Question: Name the type of graph shown.
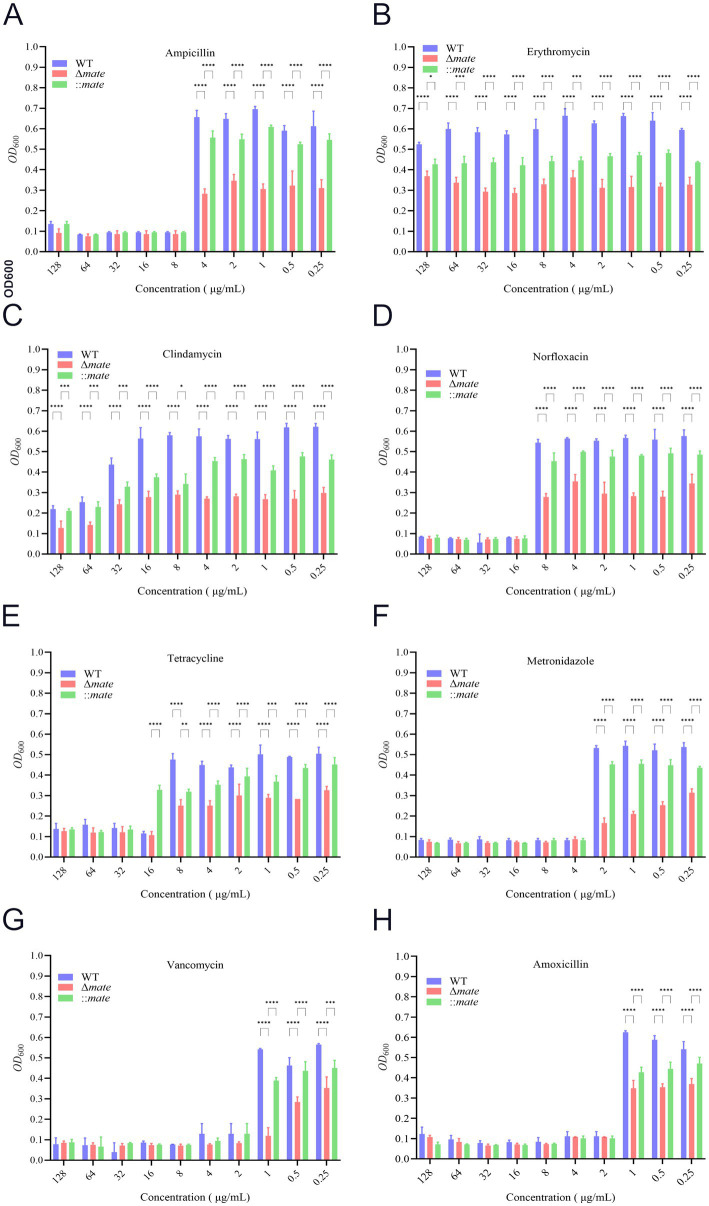
Answer: bar